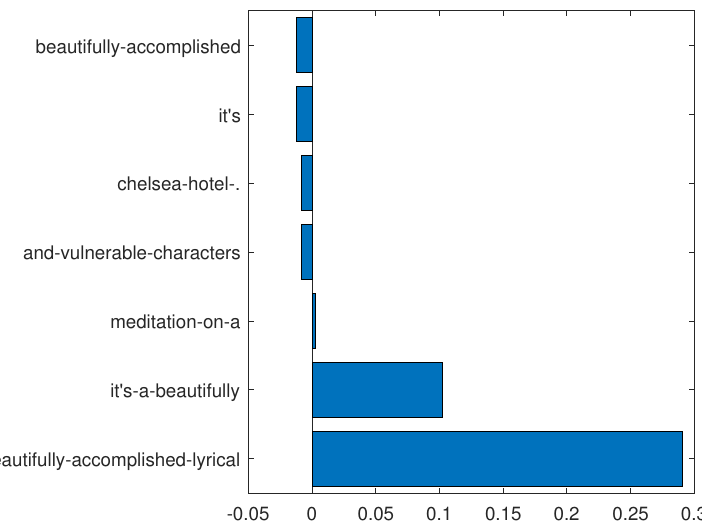
Figure 14. N-grams determined from R 24 and the following “tweet”: “it’s a beautifully accomplished lyrical meditation on a bunch of despondent and vulnerable characters living in the renown chelsea hotel . . .”. The sum of the n-grams linear contributions is 0.355.